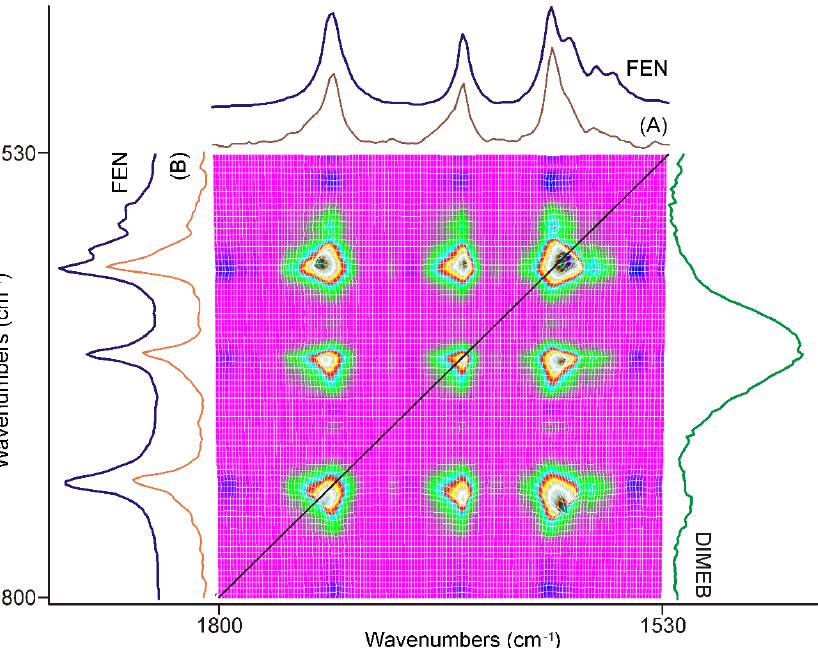
Figure 4. Part of the synchronous correlation surface was calculated from the spectra recorded during the first 20 min of grinding, between 1800 and 1530 cm − 1 . Diagonal peaks, marked with the black line, showed a strong positive correlation for all three peaks with each other in the region. The axial sessions taken at 1728 cm − 1 (A) and 1651 cm − 1 (B) showed that only the peak intensities of FEN were affected.